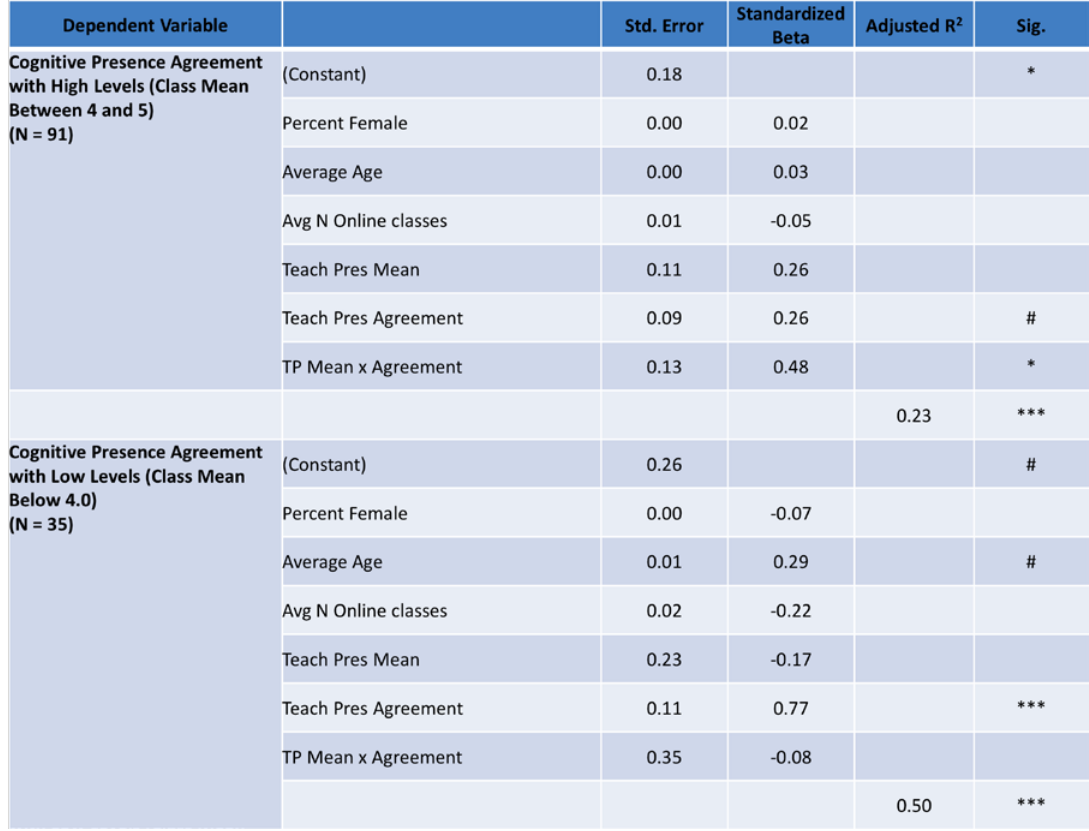
Effect of Class Teaching Presence on Agreement About Cognitive